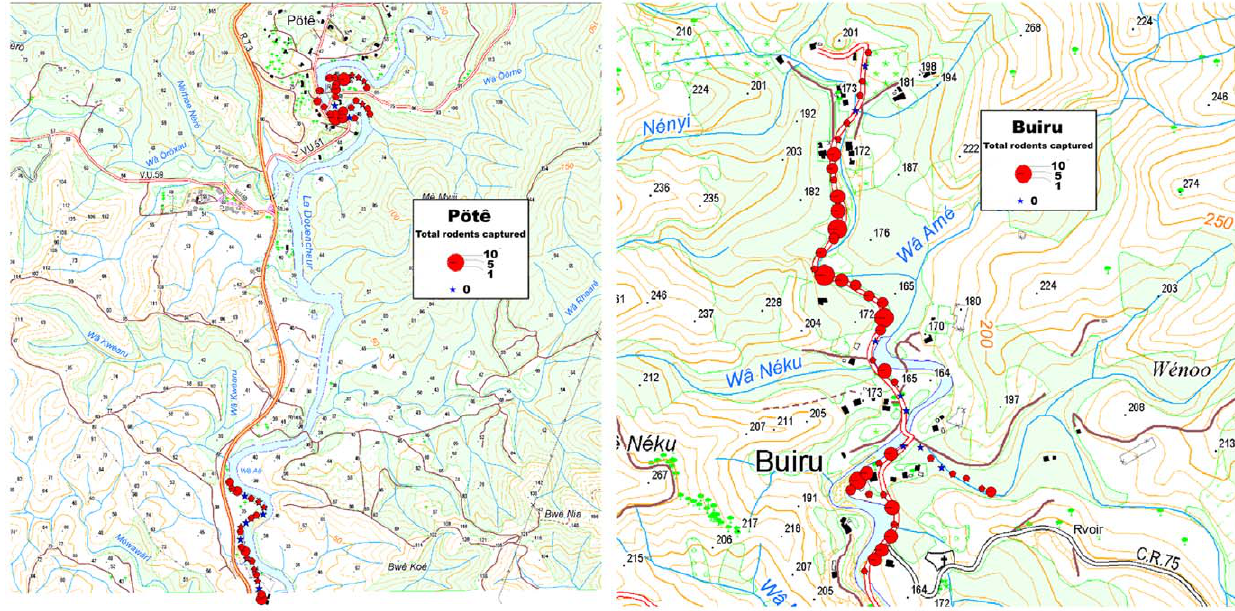
Figure 2. Localization of the trapping stations and cumulated trapping success over the study. Households have been colored in black. The geo-referenced map was kindly provided by DITTT, Government of New Caledonia.